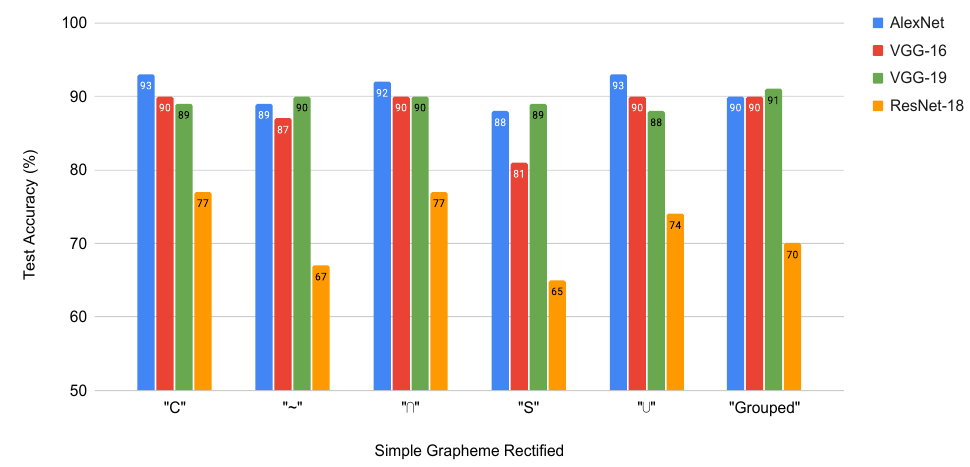
Figure 7. Rectified Simple Grapheme Test accuracy with AlexNet, VGG-16/VGG-19 and ResNet-18 networks.